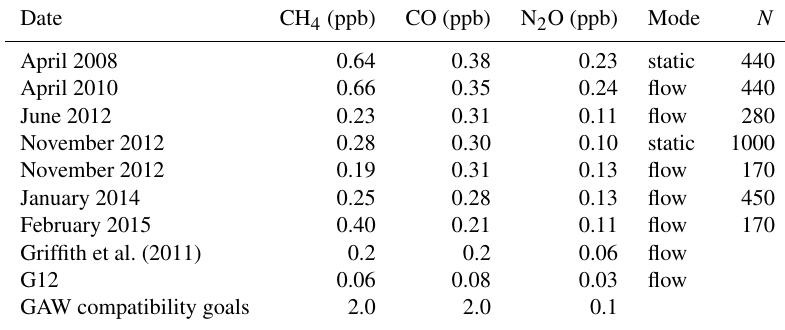
Table 2. CH 4 , CO and N 2 O 10min Allan deviation estimates measured at Lauder along with estimates from Griffith 2011 and G12. The GAW recommend compatibility goals are also listed for comparative purposes. The measurement mode and number of 1min data points ( N ) used in each Allan variance analysis experiment are